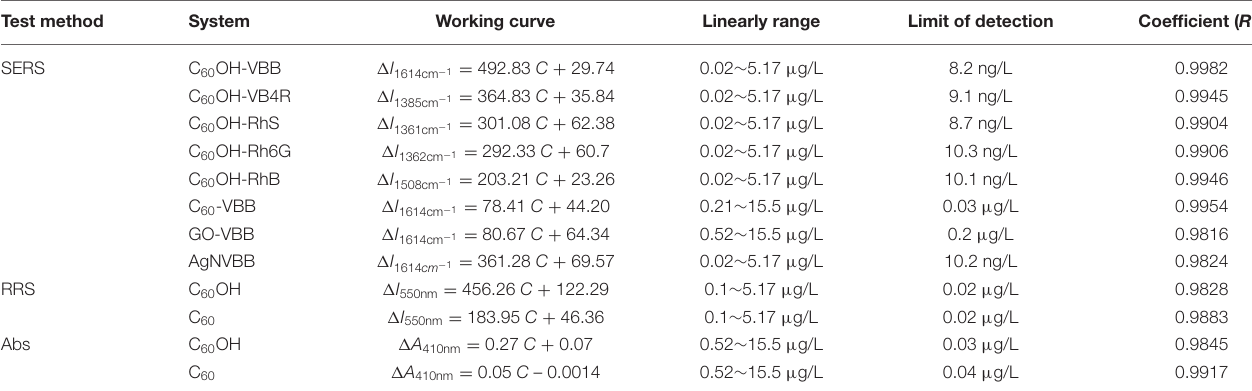
TABLE 2 | Analytical characteristics of the aptamer adjust catalysis-Ag nano plasma SERS for the determination of IPS. Test method System Working curve Linearly range Limit of detection Coefficient ( R 2